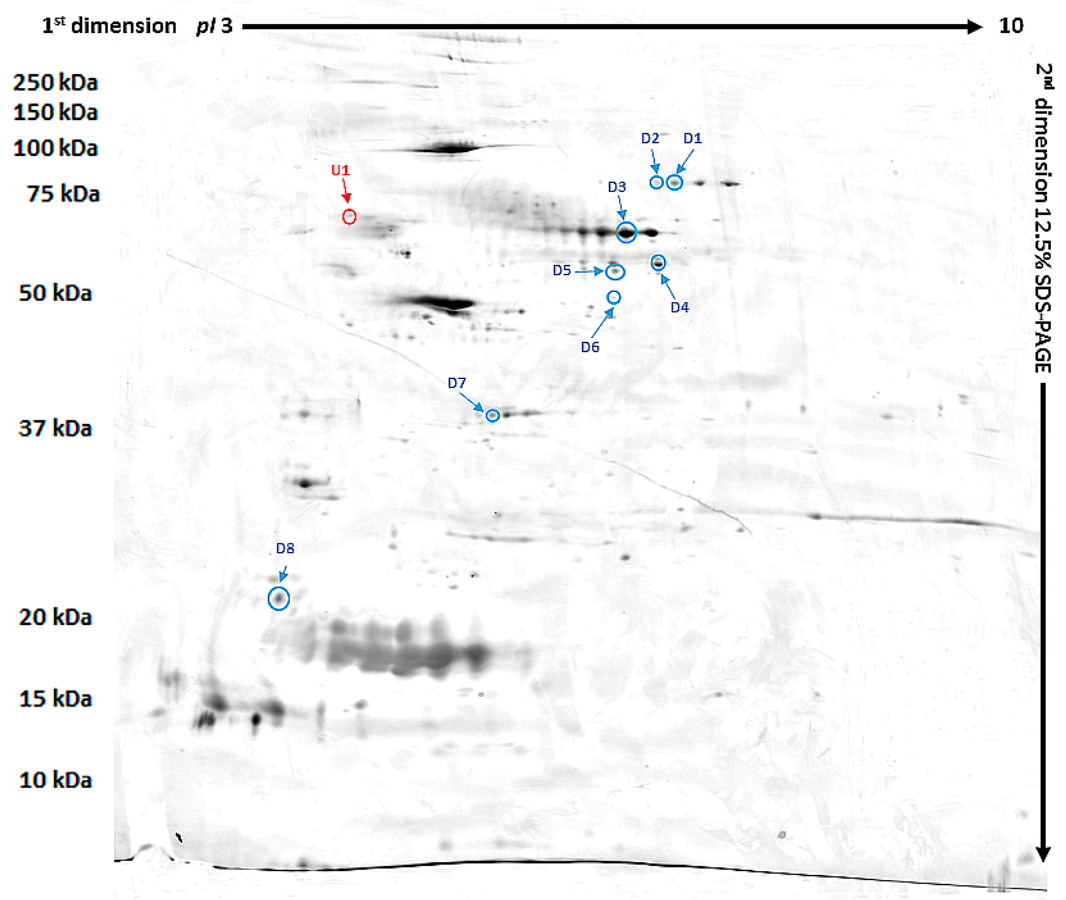
Figure 2. Fused image showing the condensed spot patterns from the experiment. Downregulated proteins are marked in blue while the upregulated proteins are marked in red.